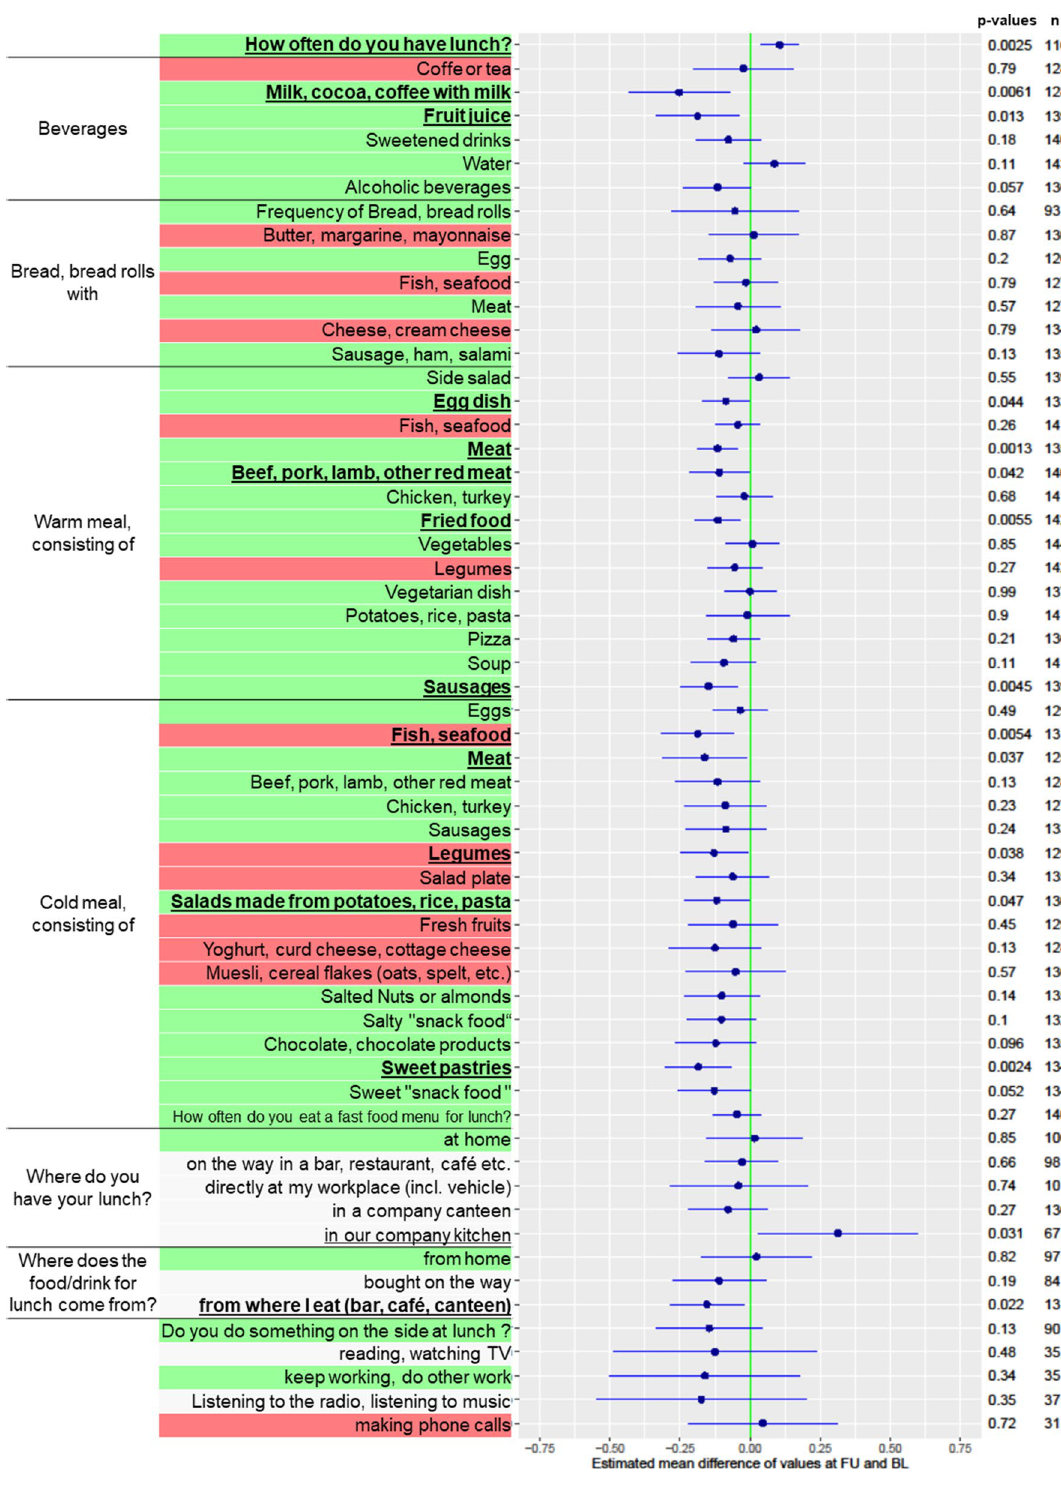
Figure 4. Change in nutrition (at lunchtime) per questionnaire item of the LEI score for the entire cohort. Raw p-values in columns, items underlined and bold when < 0.05, n = number of cases, highlighted green = difference towards direction of desired behavioral changes, highlighted red = difference towards direction of undesired behavioral change, highlighted gray = no rating, indifferent. Graph was created with R 12